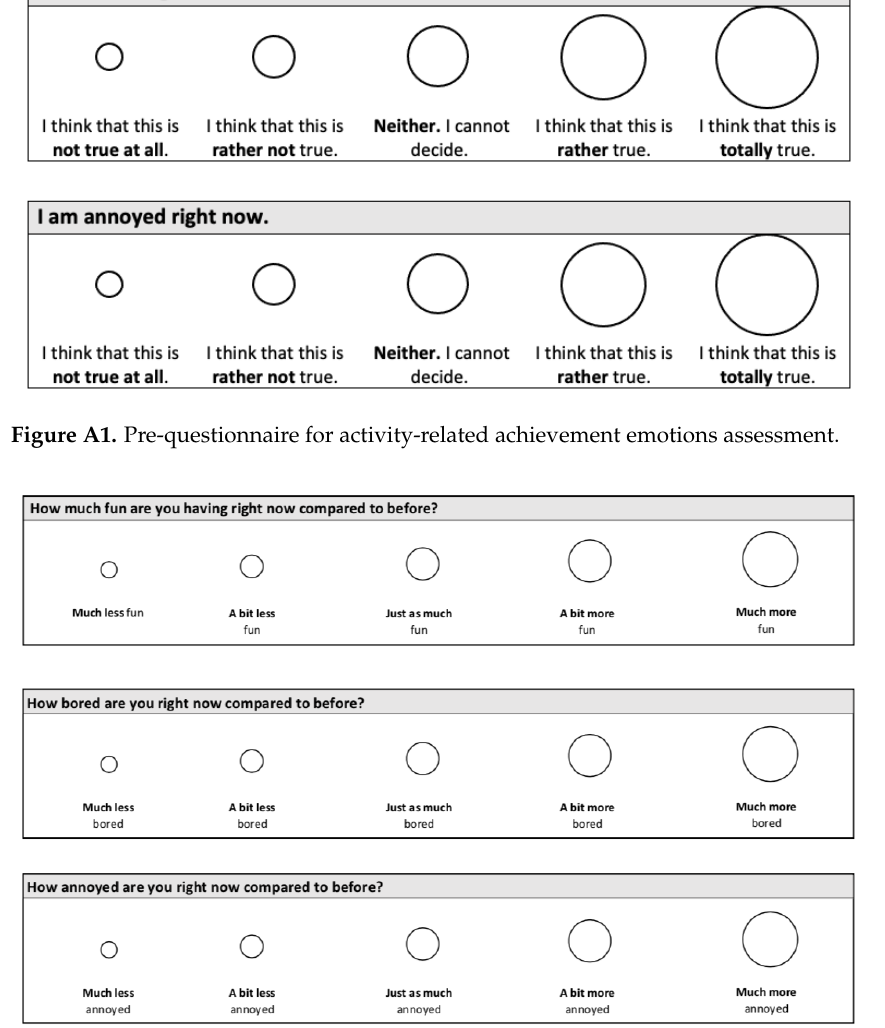
Figure A2. Post-questionnaire for activity-related achievement emotions assessment.